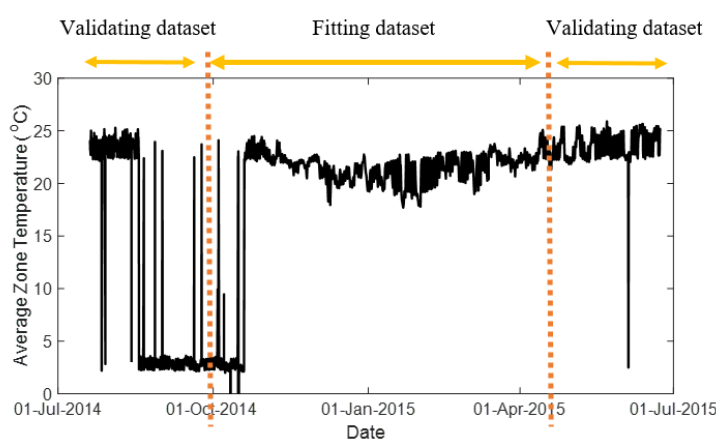
Figure 8. The ventilation system output.